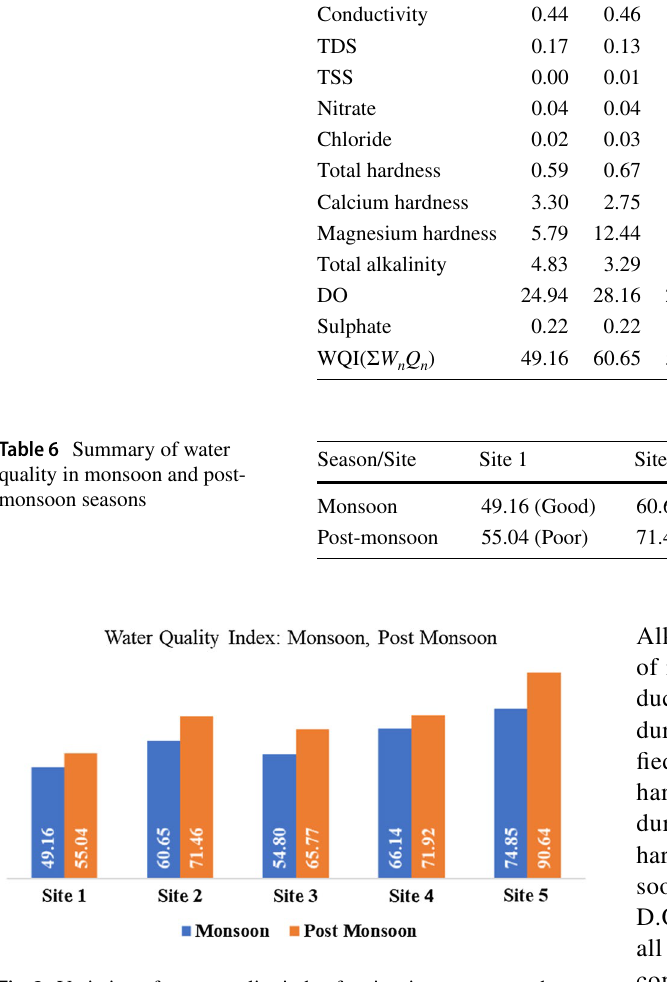
Table 5 Water Quality Index (WQI) of sites during monsoon and post-monsoon season